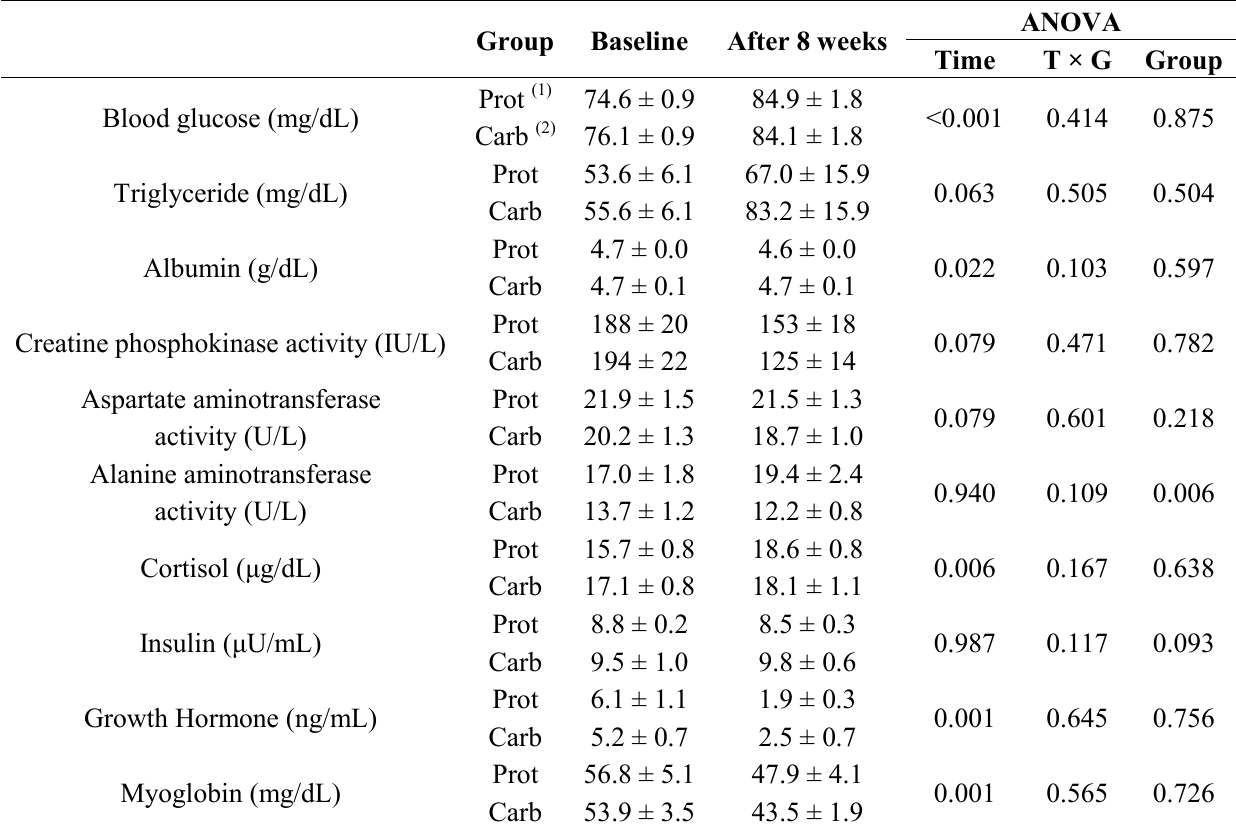
Table 3. Blood biochemistry. All values are expressed as mean ± SE. ANOVA, a repeated two-way analysis of variance. T × G, time × group interaction